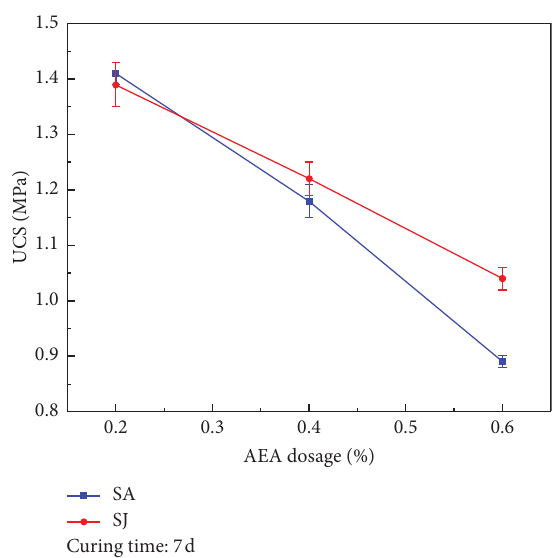
Figure 7: Variation characteristics of AEACPB strength with AEA